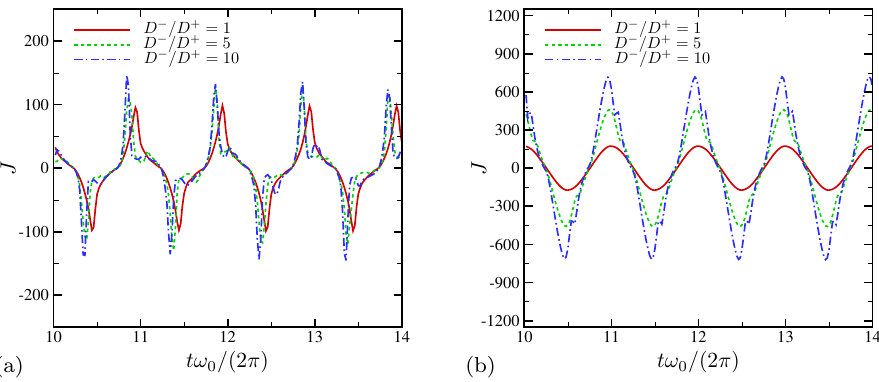
Figure 24. Surface current per unit area for ( a ) ω 0 / ( 2 π ) = 20 and ( b )